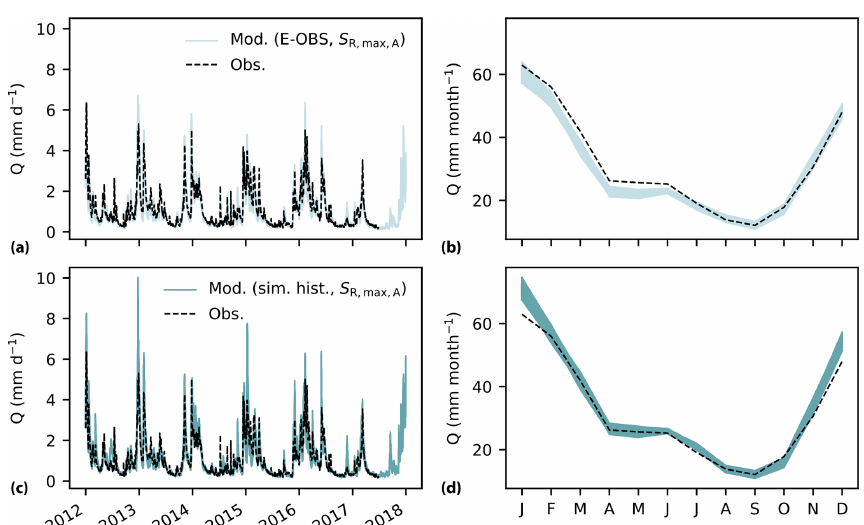
Figure 5. Observed and modeled hydrographs and mean monthly streamflow at Borgharen for the ensemble of parameter sets retained as feasible after calibration when the model is (a,b) forced with E-OBS historical data, using S R , max , A as the model parameter, and (c,d) forced with the simulated historical climate data, using S R , max , A as model